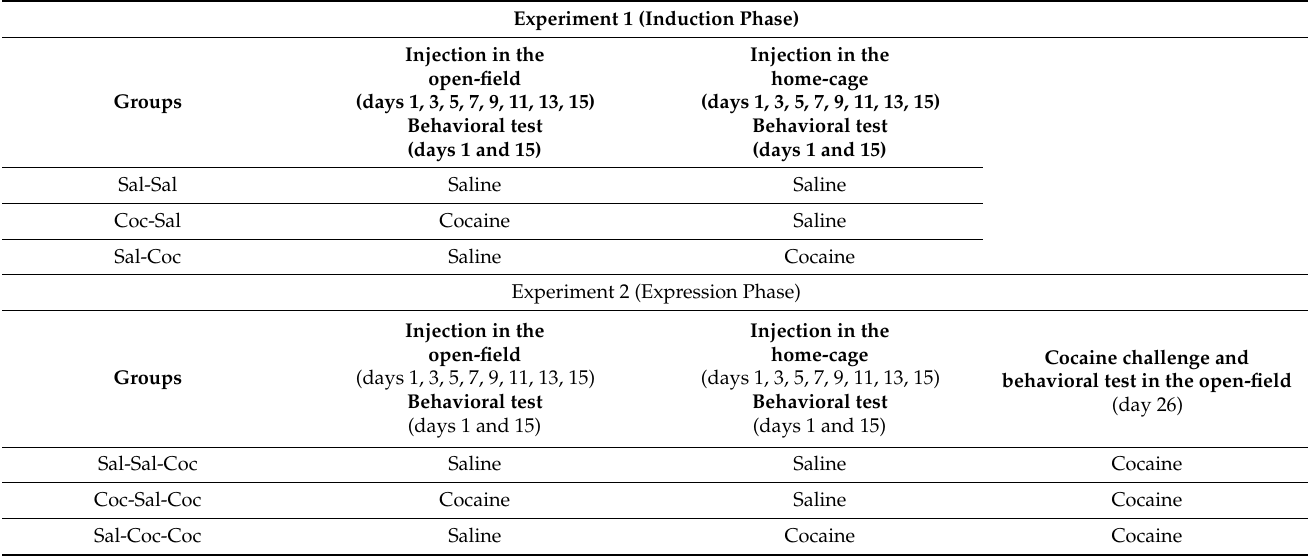
Table 1. Groups distribution according to the treatment received during the induction and expression